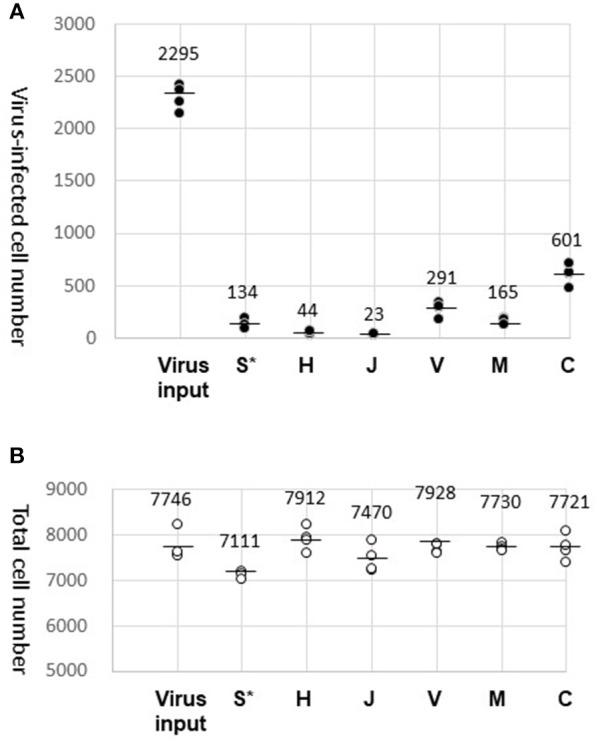
Results of virus carryover experiments. (A) Virus-infected cell number. GFP-positive cell counts (average of three different view fields of 10 mm2) were obtained for four wells and plotted (dark dots). The mean of the four well counts is indicated by a bar. In addition to the virus carryover by the test fabrics (S, H, J, V, M, and C), the entire virus load (Virus input) in the droplet (40 μL) were also examined. (*After attachment of the droplet, fabric S was directly submerged in the well of HeLa cell culture). (B) Total cell number. Hoechst-stained cells were counted and plotted in the same way as in (A) (circles).